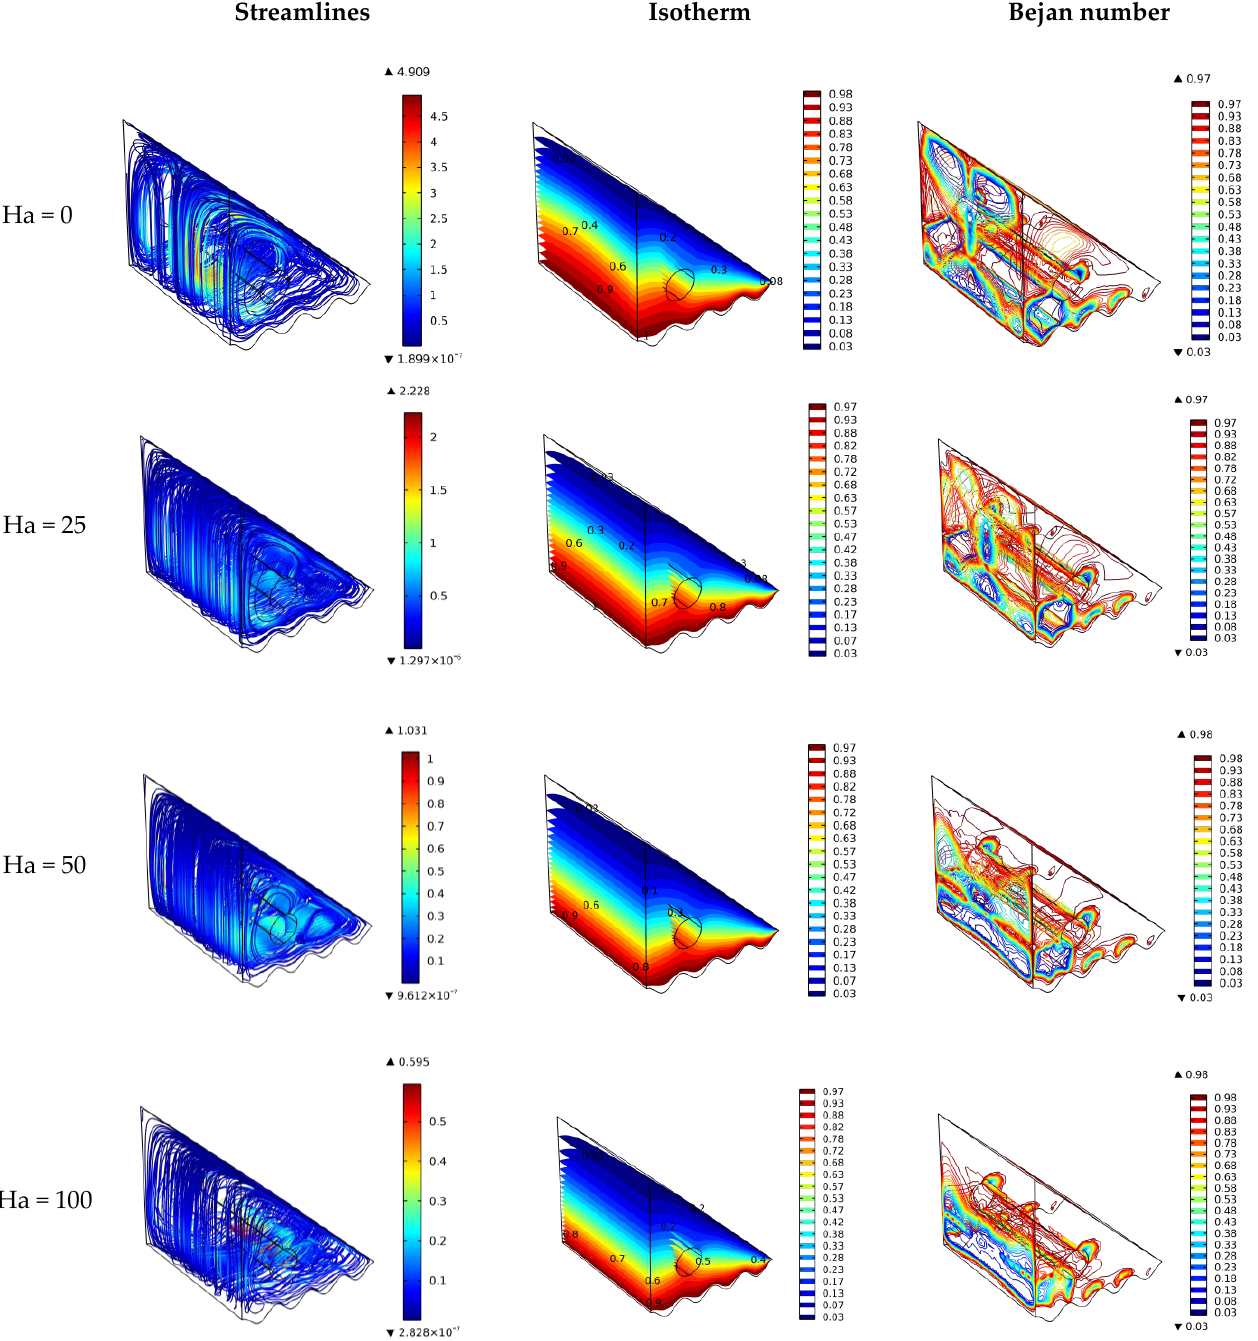
Figure 4. Surface plots of velocity, temperature, and Bejan number for various Hartmann numbers.